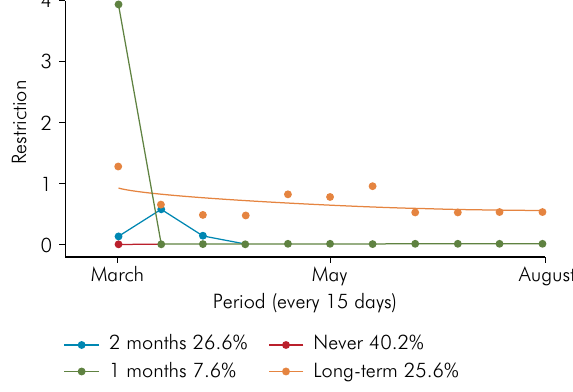
Figure. The trajectory of dentistry activity restriction in Brazilian municipalities (n = 5,564).